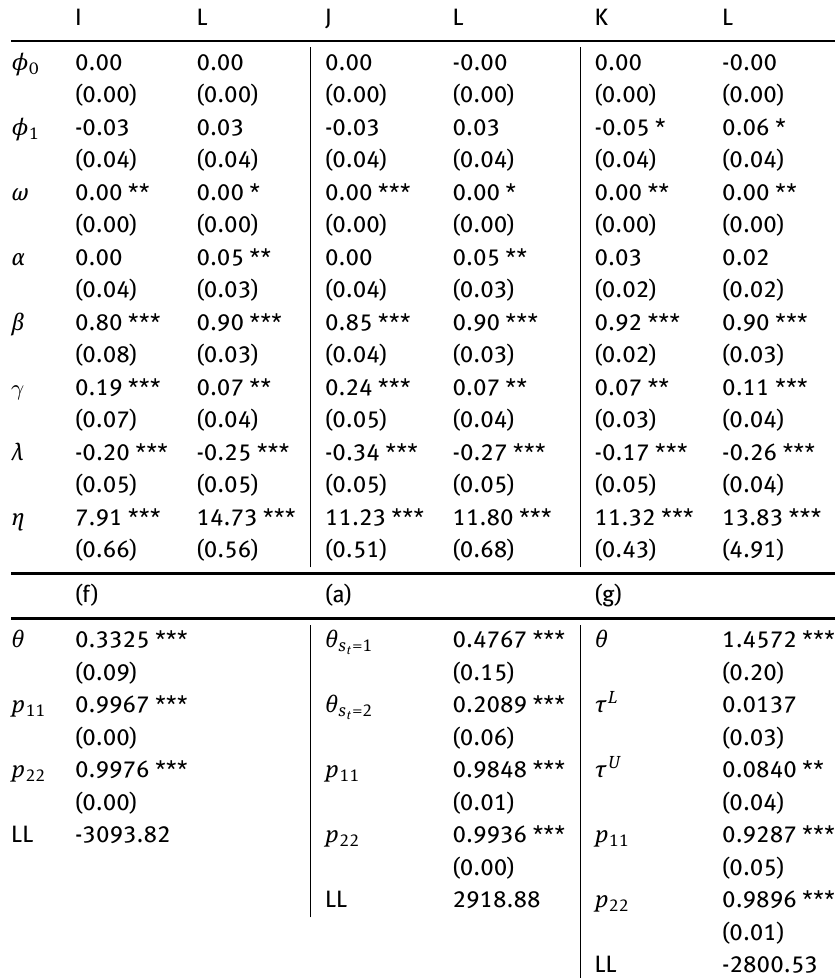
Table 8c: Parameter estimates for the joint distribution using a mixture of copulas where the weights are given by the forecast probability of each